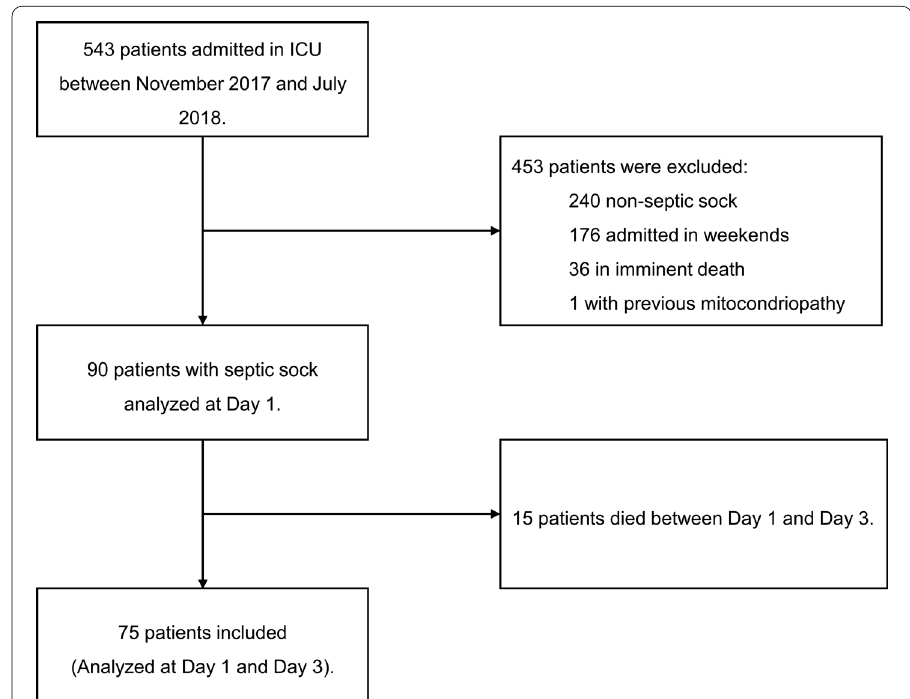
Fig. 1 Flow diagram. Ninety patients were initially engaged in the study protocol, but 15 progressed to death on day 1 of admission. Seventy-five septic shock patients completed the